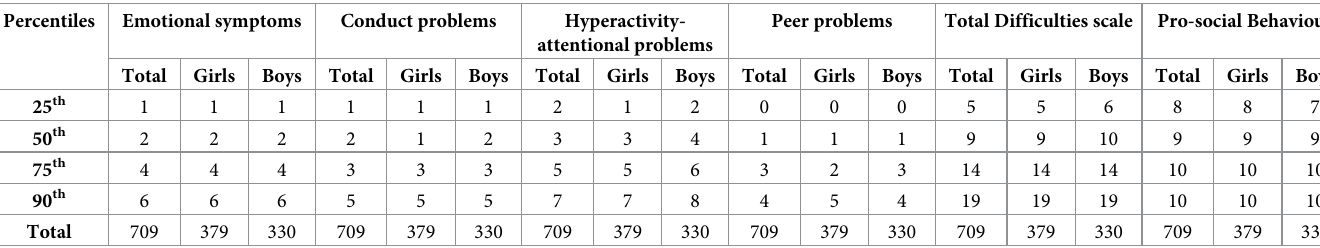
Table 8. Normative data for total scores by sex based on parental report, age group 9–11.